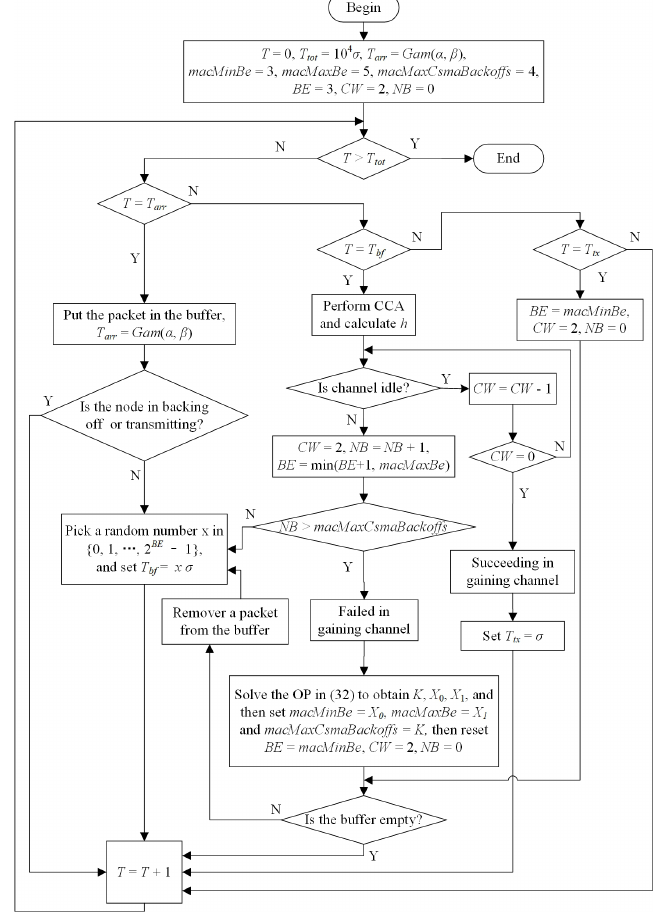
Figure 3. The procedure of the ECCE simulation